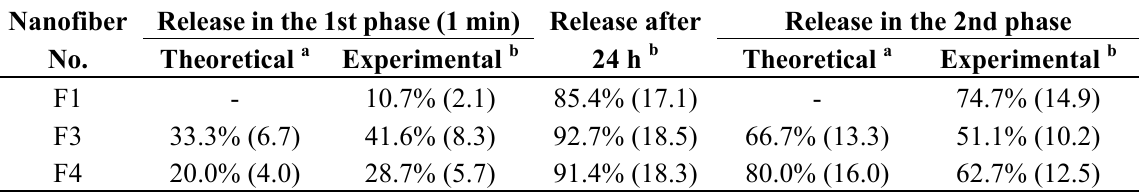
Table 2. Comparison of the release parameters of the nanofibers ( n =